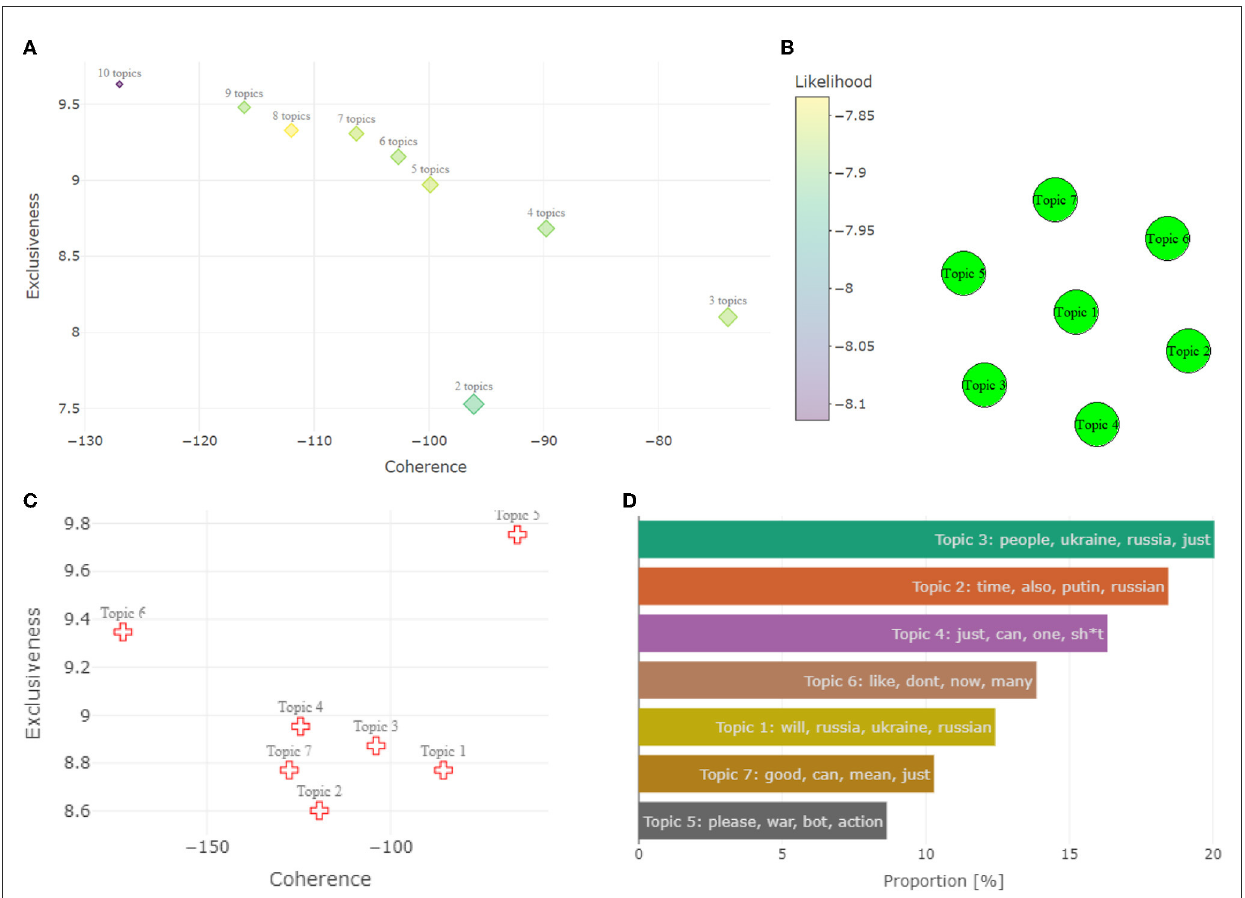
FIGURE7 Extensive topic modeling visualizations. (A) Top left model selection results with four distinct diagnostics. In addition to the exclusiveness, coherence, and number of topics, the sizes of each marker relate to the residual diagnostic values. (B) Top right correlation between topics. (C) Bottom left exclusivity and coherence for the individual topics. (D) Bottom right topic proportions in the data set.